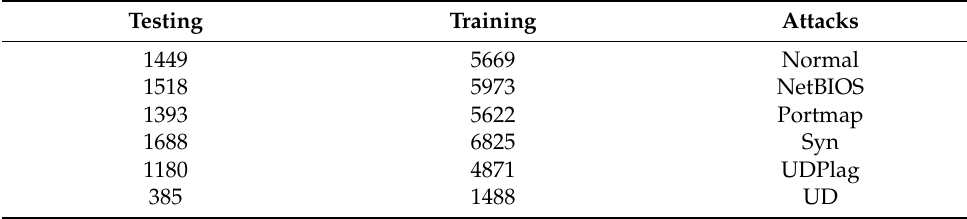
Table 2. Dataset after dividing into training and